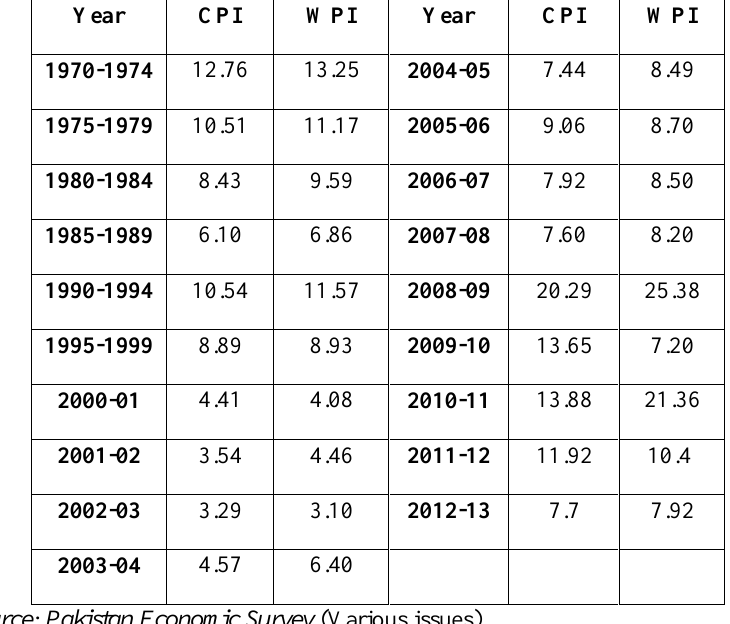
Table 1:Trends in CPI and WPI Based Inflation (1970-71 to